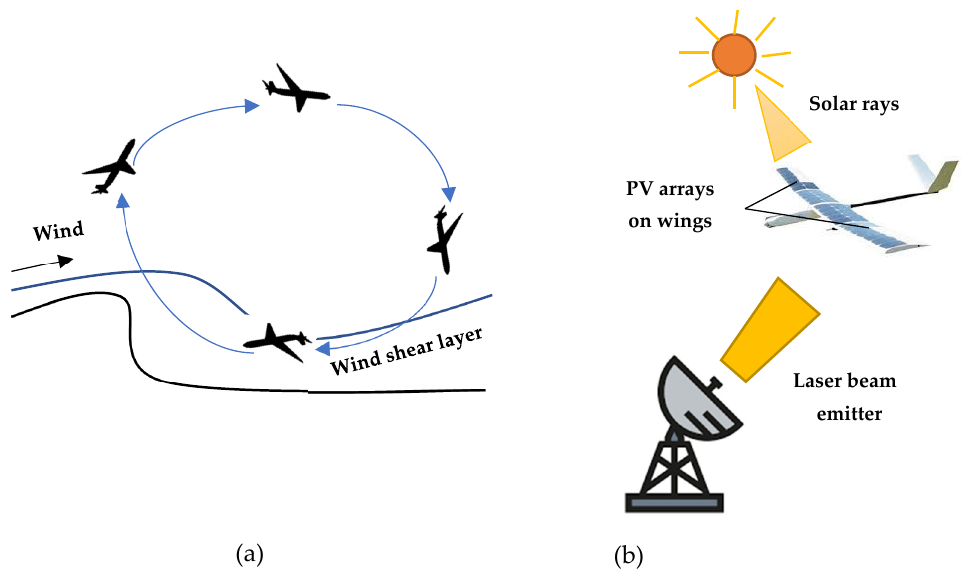
Figure 13. Non-EMF-based techniques: ( a ) gust soaring; ( b ) PV arrays and laser beaming.